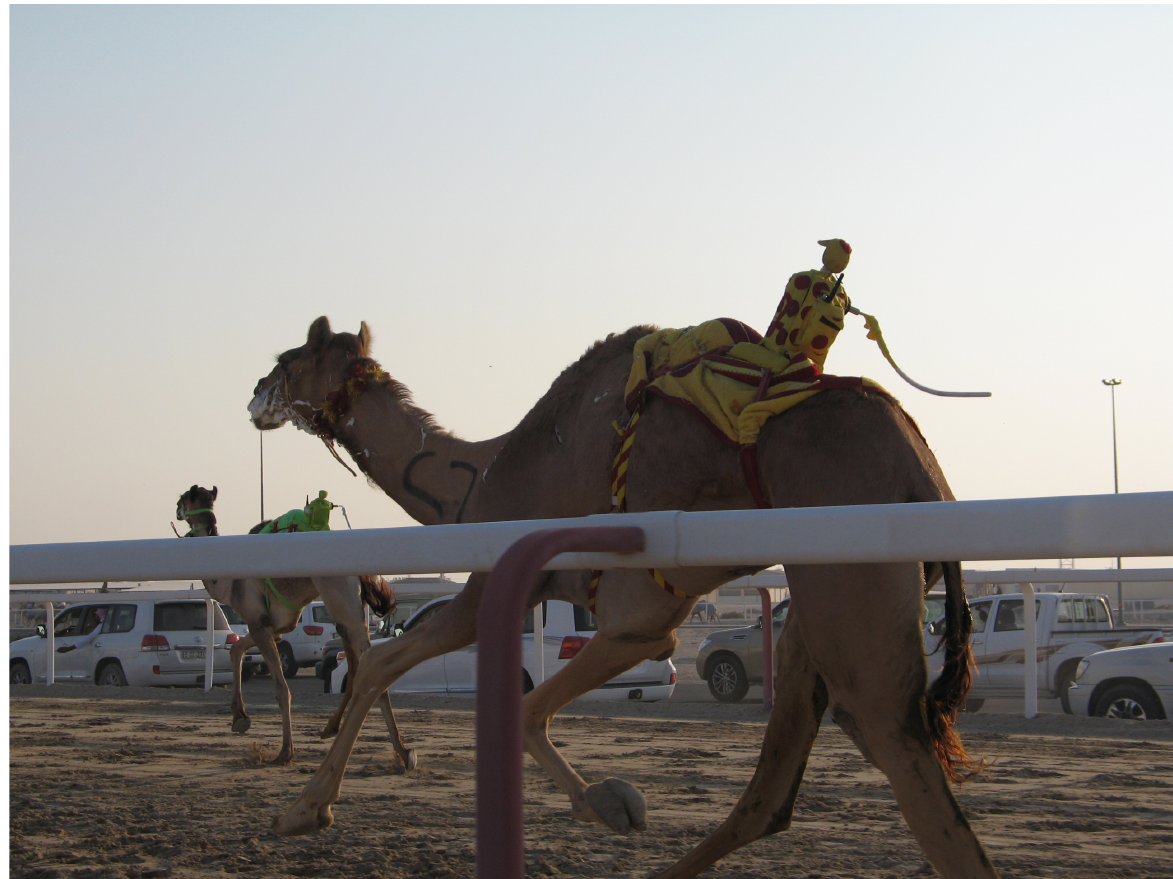
Figure 3. Camel race in Al-Shahaniya. The owners are following the race with their cars (December 2014). Source: Sarah